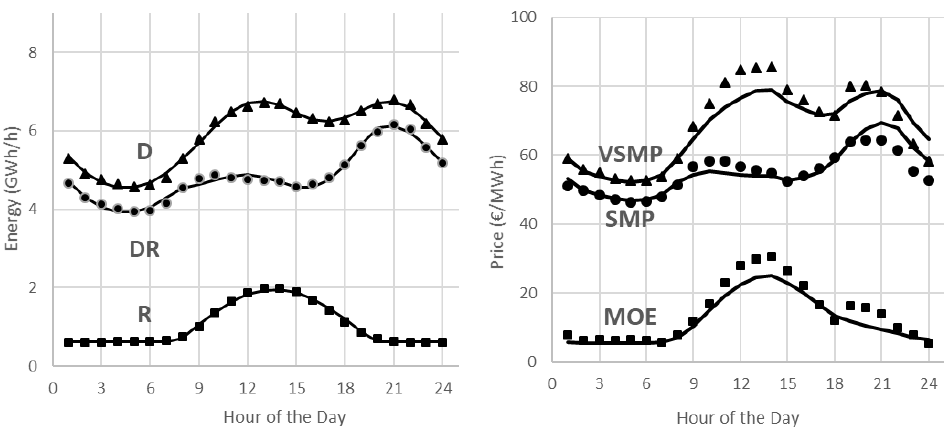
Figure 9. Daily variation: Comparison between real (points) and model calculated (lines) values. D = demand, DR = demand renewables, R = renewables, VSMP = virtual system marginal price, SMP = system marginal price, MOE = merit order effect.